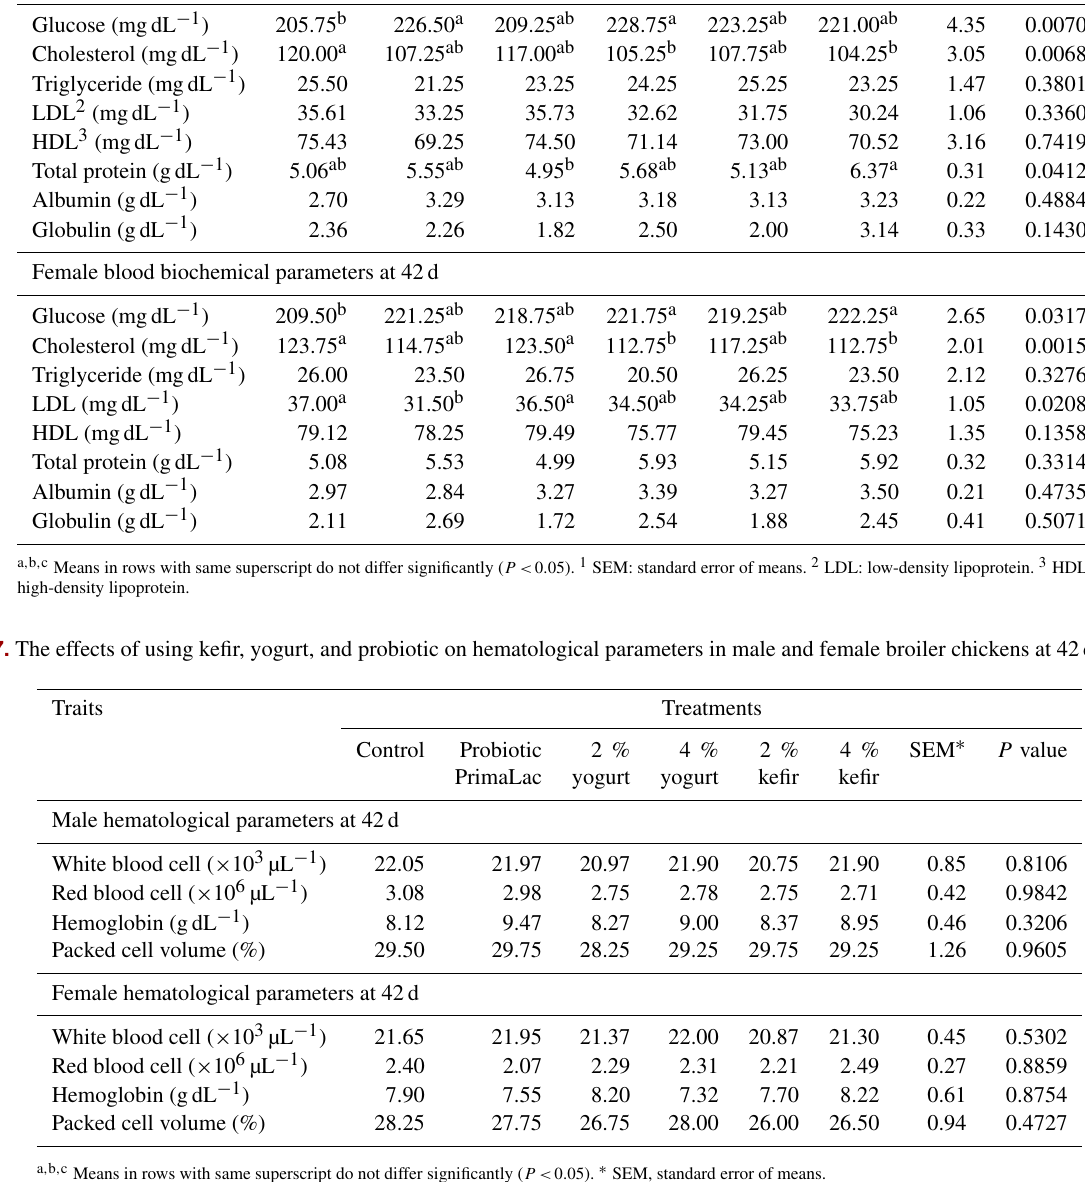
Table 6. The effects of using kefir, yogurt, and probiotic on blood biochemical parameters in male and female broiler chickens at 42 d. Traits Treatments Control Probiotic 2 % SEM ∗ P value PrimaLac yogurt yogurt